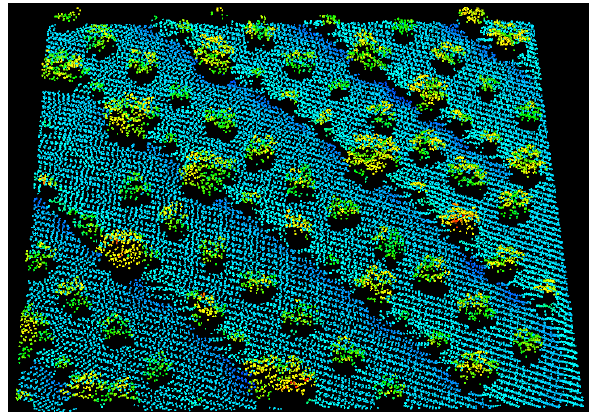
Figure 1. Plot of ALS point cloud of a part of the study